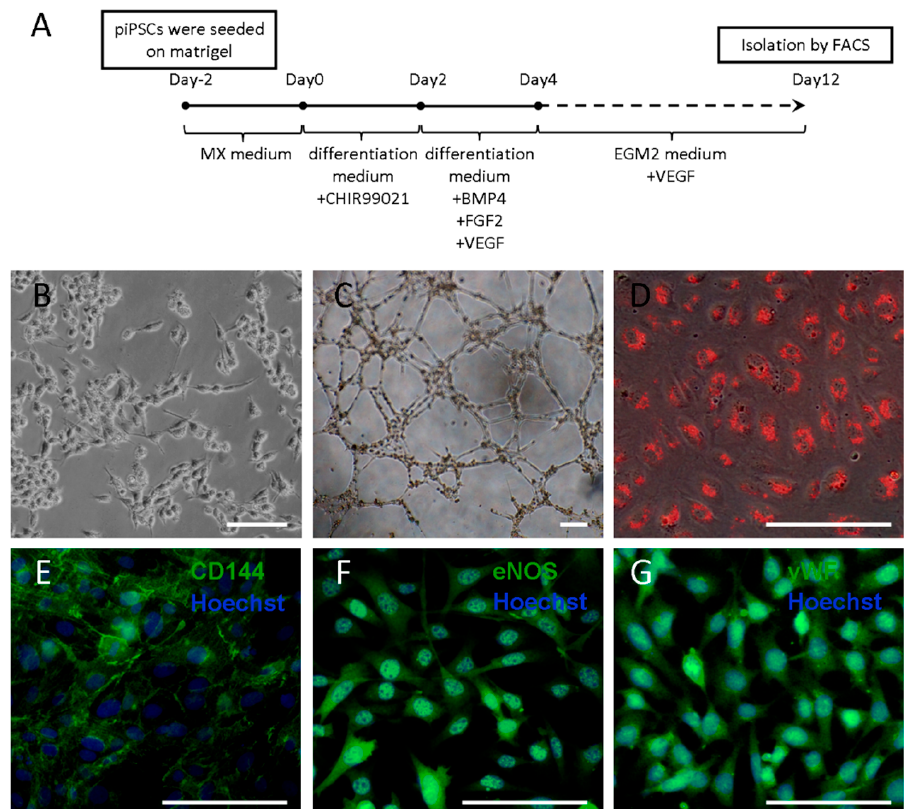
Figure 1. Generation and characterization of piPSC ‐ ECs. ( A ) The schematic diagram for piPSC ‐ EC derivation. ( B ) Morphology of piPSC ‐ ECs. ( C ) Tube ‐ like structures were formed by piPS ‐ ECs. ( D ) Uptake of Dil ‐ Ac ‐ LDL by piPSC ‐ ECs. ( E – G ) Endothelial ‐ specific markers were detected via immunofluorescence staining. piPSC ‐ ECs were positive for CD144 ( E ), eNOS ( F ) and vWF ( G ). Blue fluorescence represents the nuclei labeled by Hoechst33342. Scale bar = 50 μ m.